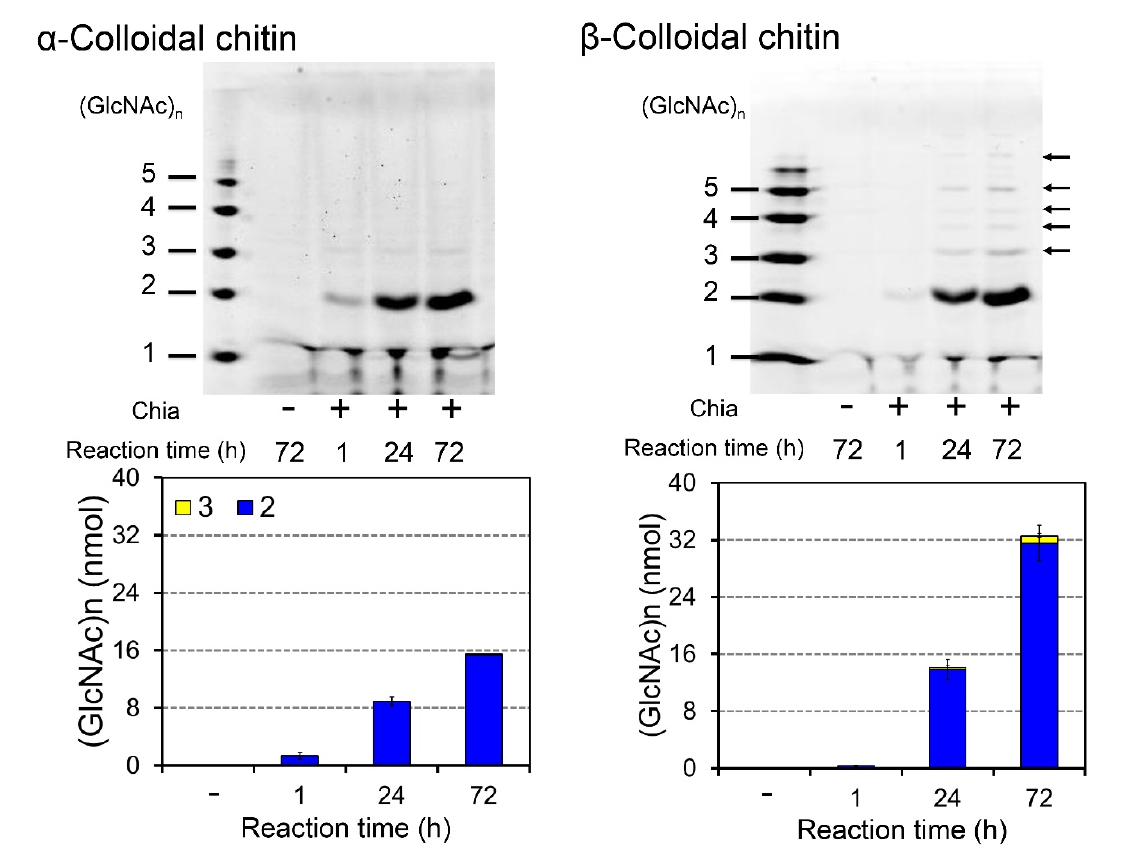
Figure 1. Degradation of α - and β -chitin substrates by Chia. α -colloidal or β -colloidal chitin was incubated with Chia at pH 2.0 for 1, 24, or 72 h. The resulting products were analyzed by the FACE method as described in the Materials and Methods. Chitin oligomers are shown in the left margin as standards. Recombinant Chia degraded α -chitin ( left ) and generated primarily dimers, whereas GlcNAc oligomers of variable sizes were produced from β -chitin ( right ). The data quatification is shown in lower panels.